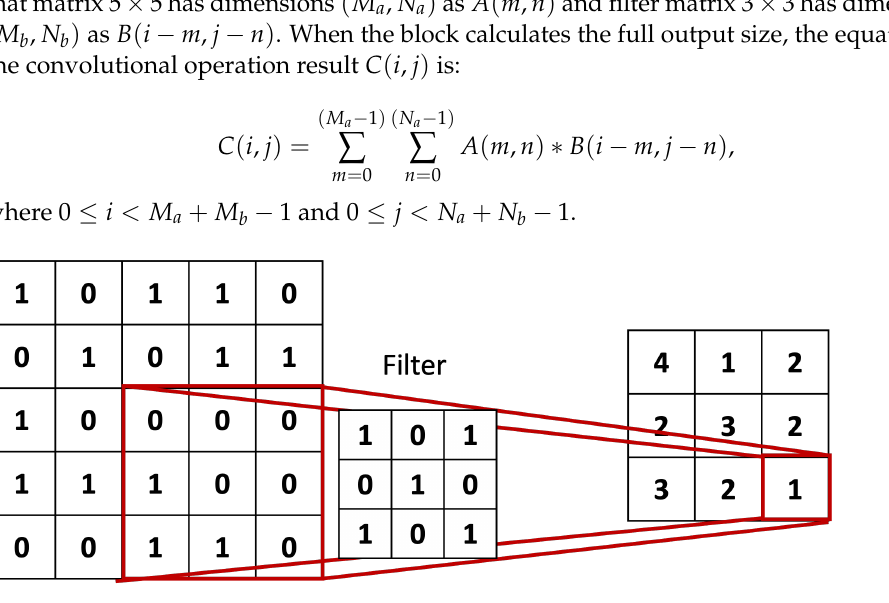
Figure 3. The convolutional operation and the numbers 0–4 are from Equation